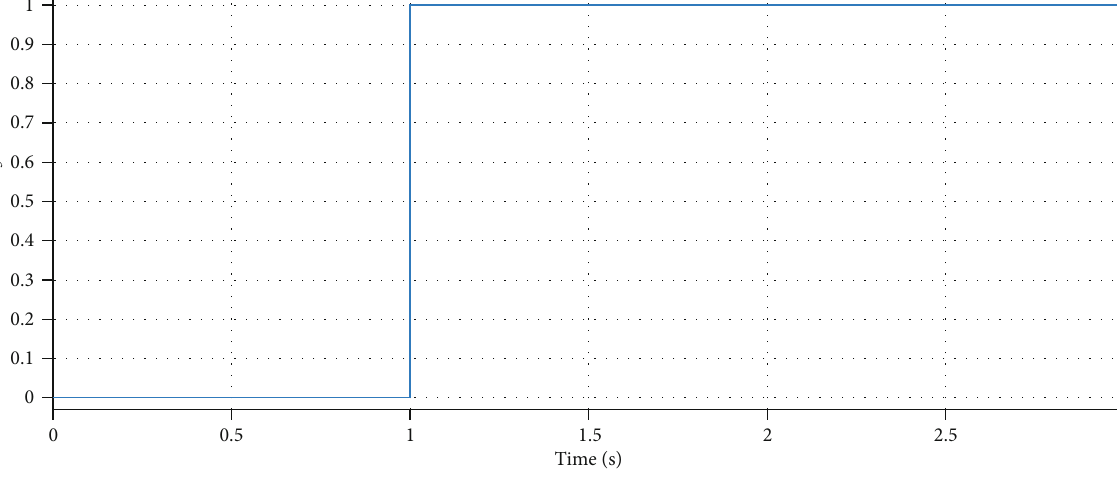
Figure 16: Switch K